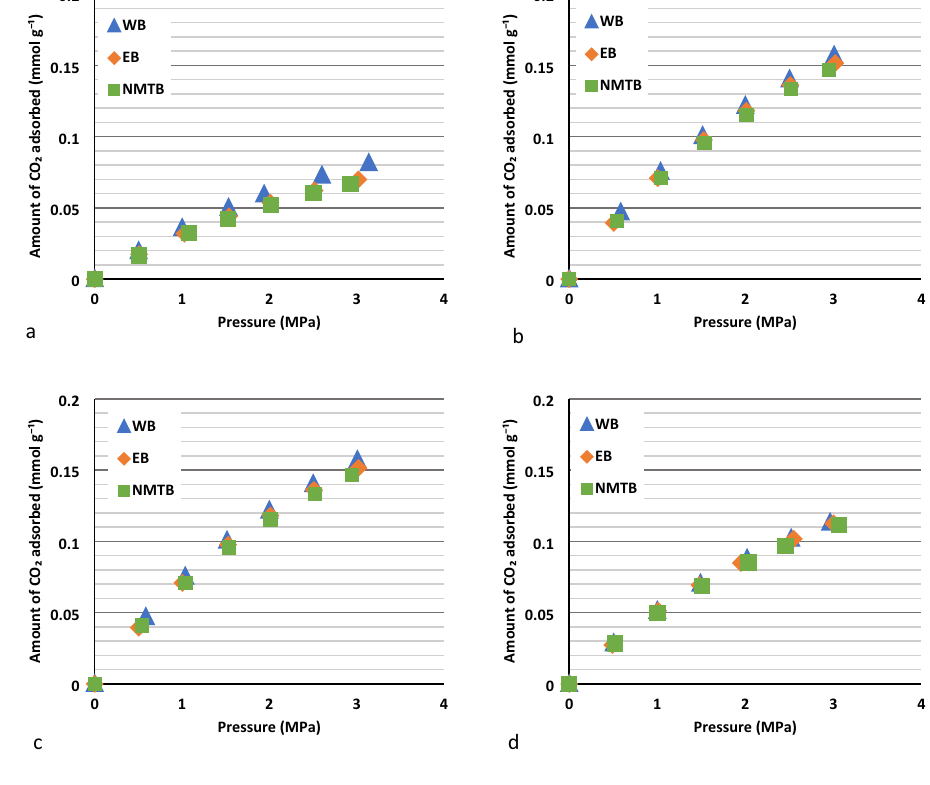
Fig. 8 CO 2 adsorption on the difference between coal form and moisture: a powder samples under raw conditions, b powder samples under dry condition, c block samples under raw conditions, and d block samples under dry